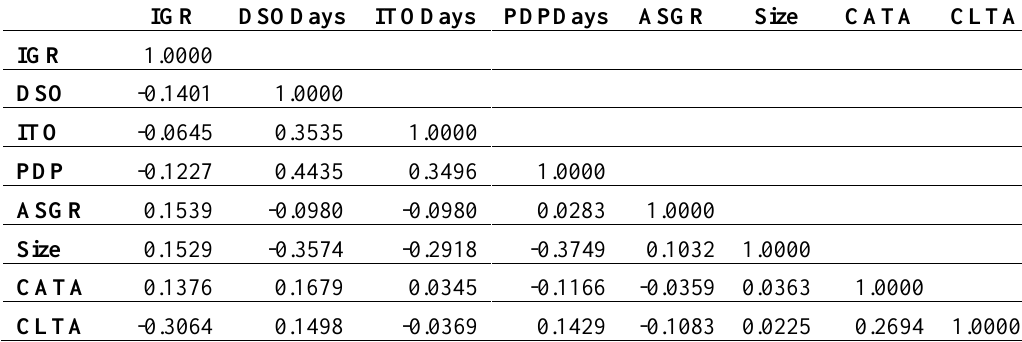
Table.2. Correlation